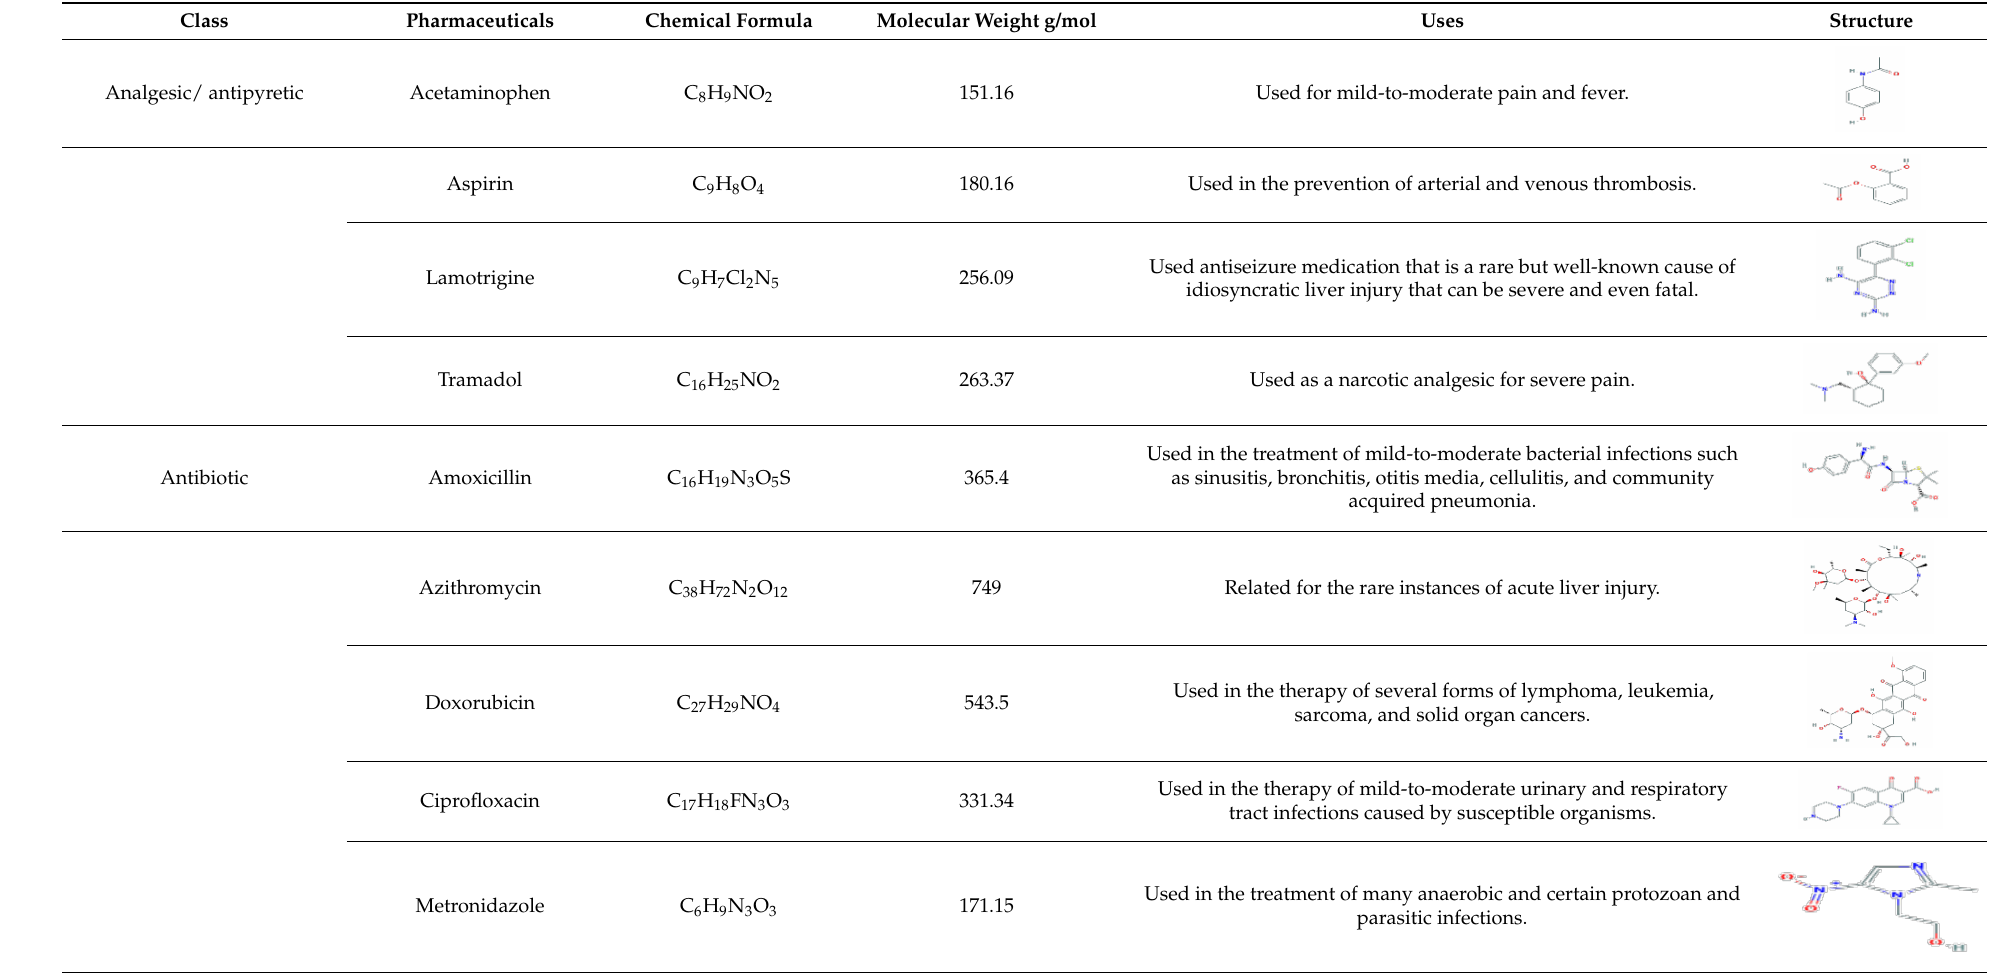
Table 1. Class and chemical structure of the most used pharmaceutical products in